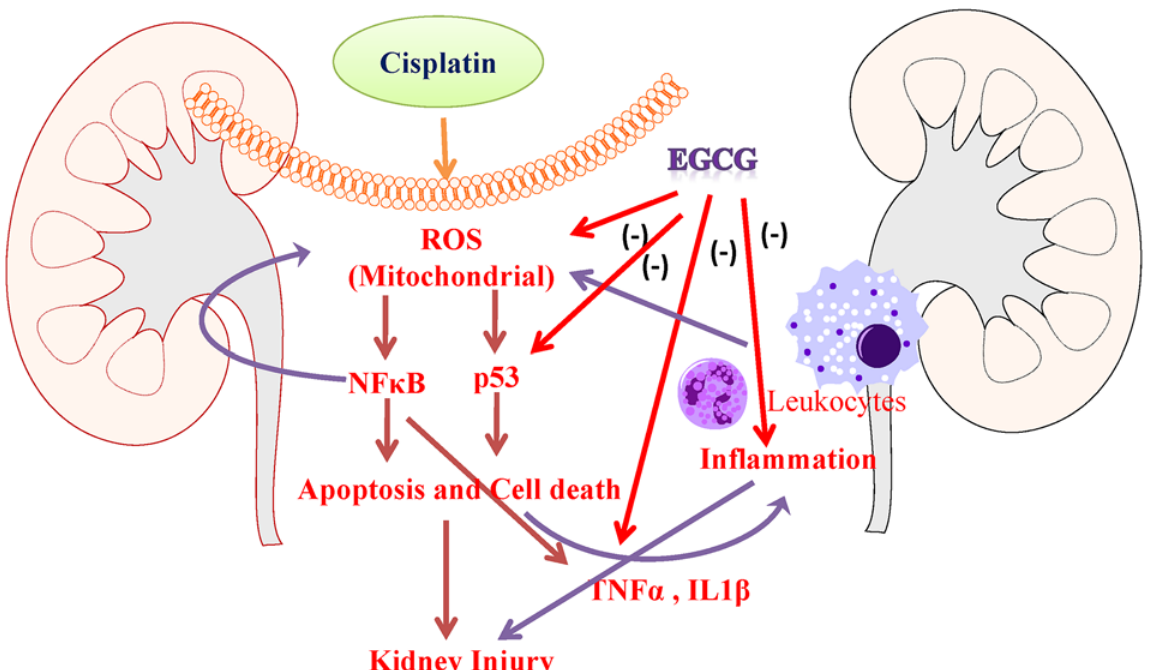
Fig 9. Schematic diagram of protection mechanism of EGCG in cisplatin induced kidney injury. EGCG inhibit cisplatin induced mitochondrial ROS (Reactive Oxygen Species) in the renal tubular cells which caused cell death. Cell death in the tubular cells leads to pro-inflammatory response with cytokines (TNF α and IL1 β ). These process leads to leukocytes infiltration with additional burst of oxidative stress. EGCG also neutralize these pro- inflammatory cytokines. All combinatorial effects leads to reduced inflammation and cell death, thus protecting against cisplatin induced kidney